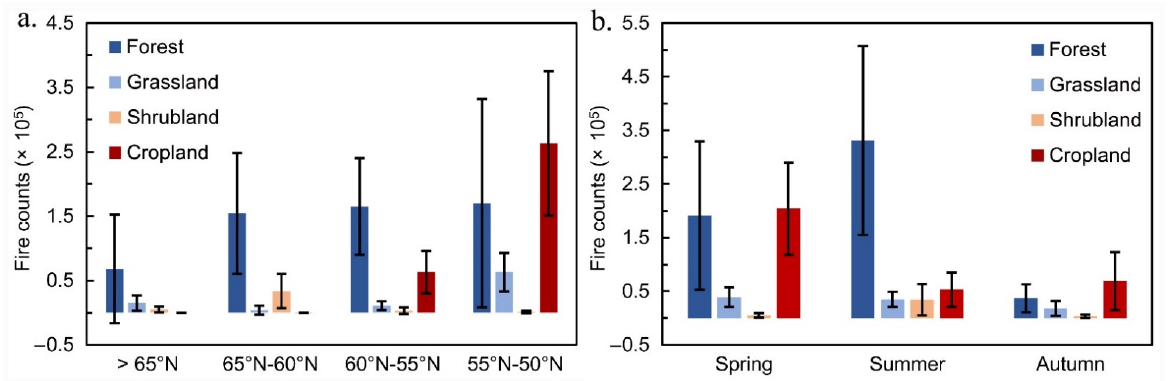
Figure 4. Zonal ( a ) and seasonal ( b ) variations in wildfire climatology on different land cover types in NEA.